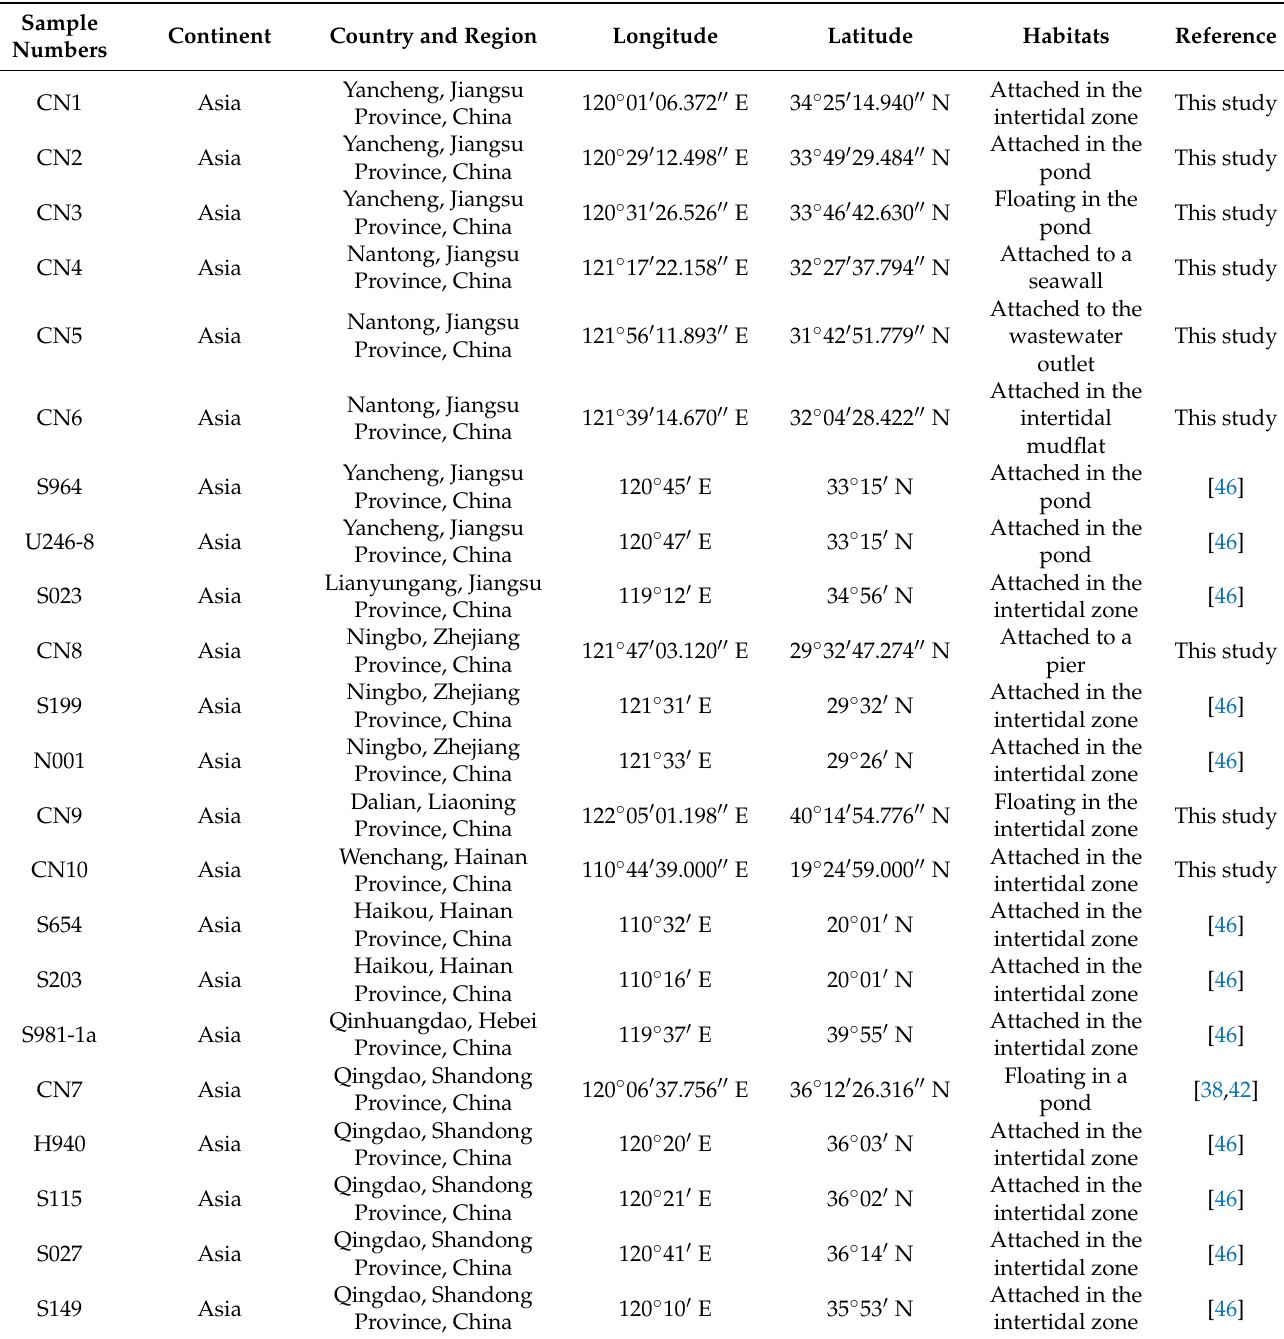
Table 1. Geographical location of the U. meridionalis sample